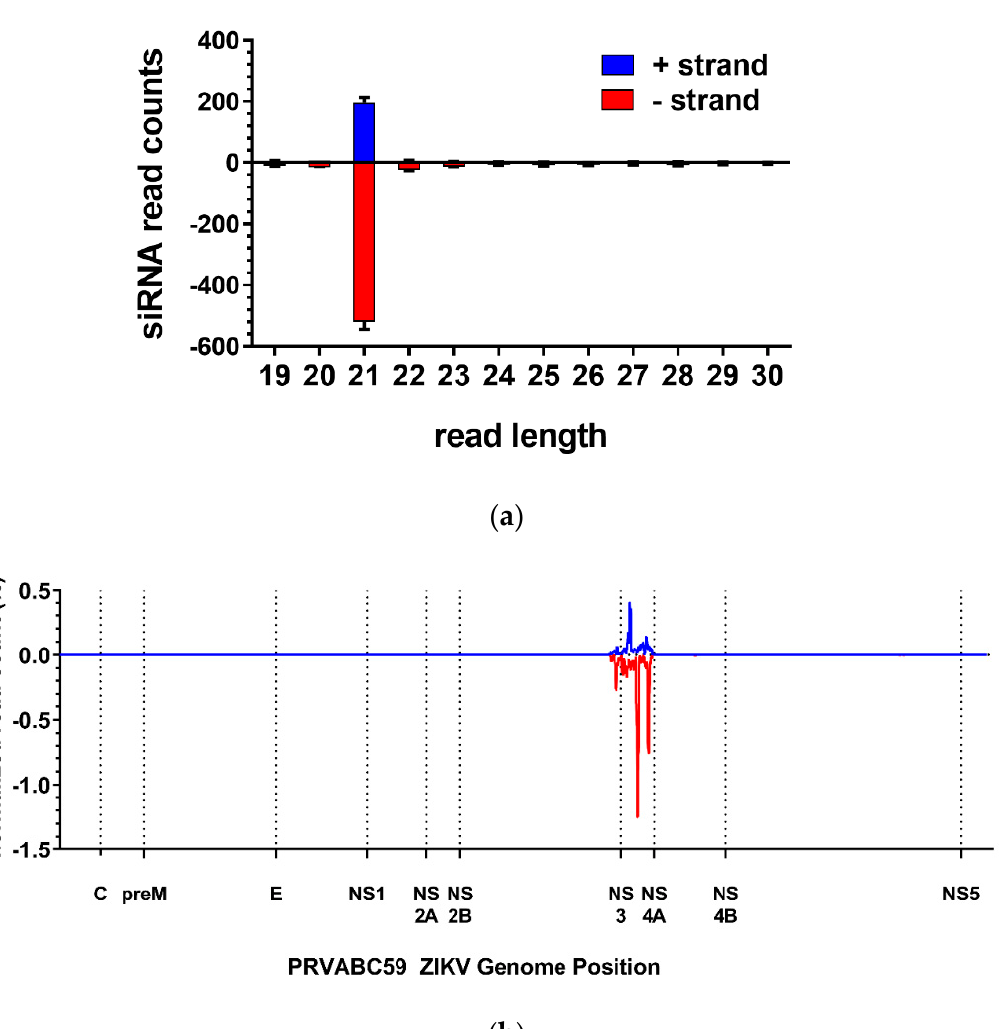
Figure Figure 3. The anti-ZIKV-NS3/4A IR effector is processed by the midgut’s RNAi machinery. ( a ) Anti- ZIKV-NS3/4A mosquitoes process the IR effector into 21 nt ZIKV-specific siRNAs. Black bars indicate mean with range error bars. ( b ) Positional analysis of ZIKV-specific siRNAs reveals that they are complementary to the NS3/4A region of the ZIKV (PRVABC59) genome, which is the region that is targeted by the transgene.